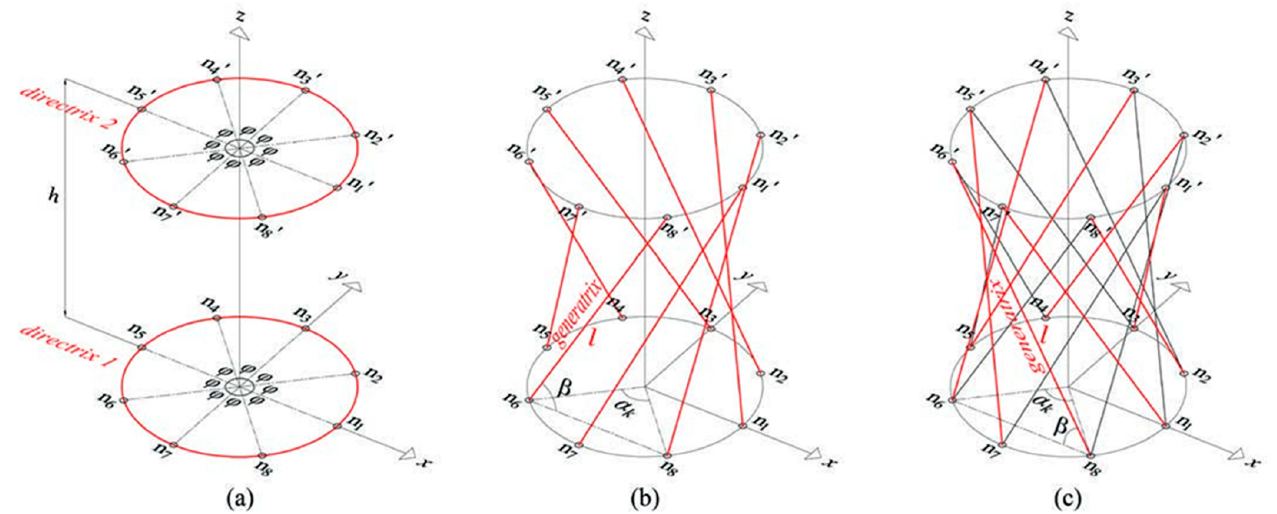
Figure 2. ( a – c ) Generation process of doubly ruled hyperboloid [17]. Reproduced with permission from Feray Maden, Geometric and Kinetic Analysis of Deployable Doubly Ruled Hyperboloids; published by MEGARON/Y ı ld ı z Technical University Faculty of Architecture E-Journal, 2017.